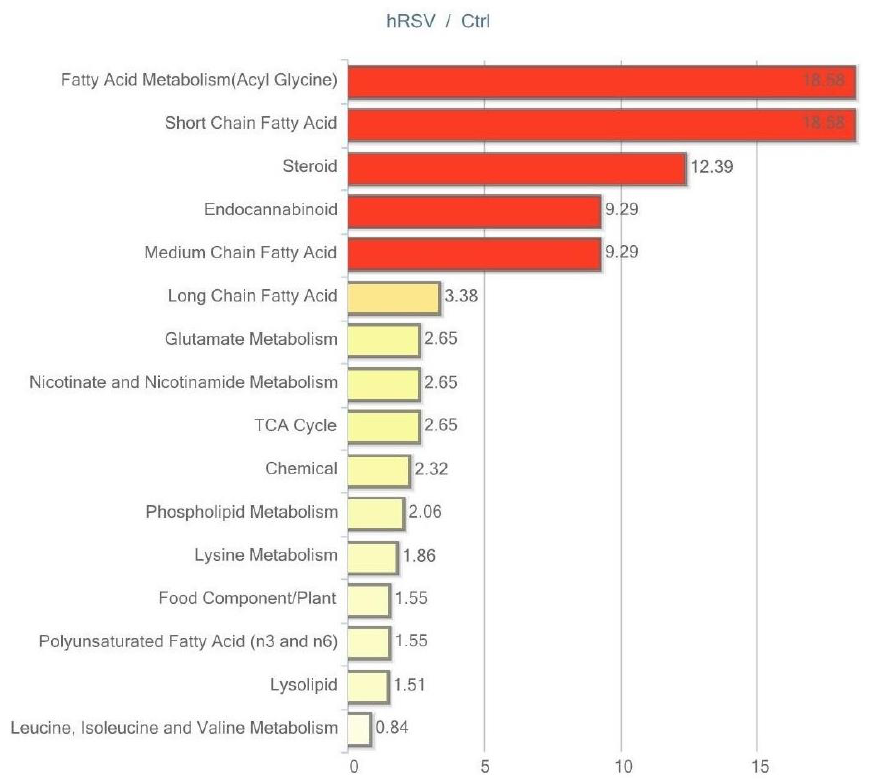
Figure 5. Resveratrol-mediated changes in skeletal muscle tissue expressed as Pathway enrichment values (PEV). Values are based on the significant resveratrol-regulated compounds relative to all detected compounds in the pathway. PEV = (number of significant metabolites in pathway/total number of detected metabolites in pathway)/(total number of significant metabolites/total number of detected metabolites); hRSV: high-dose resveratrol; Ctrl: Placebo group